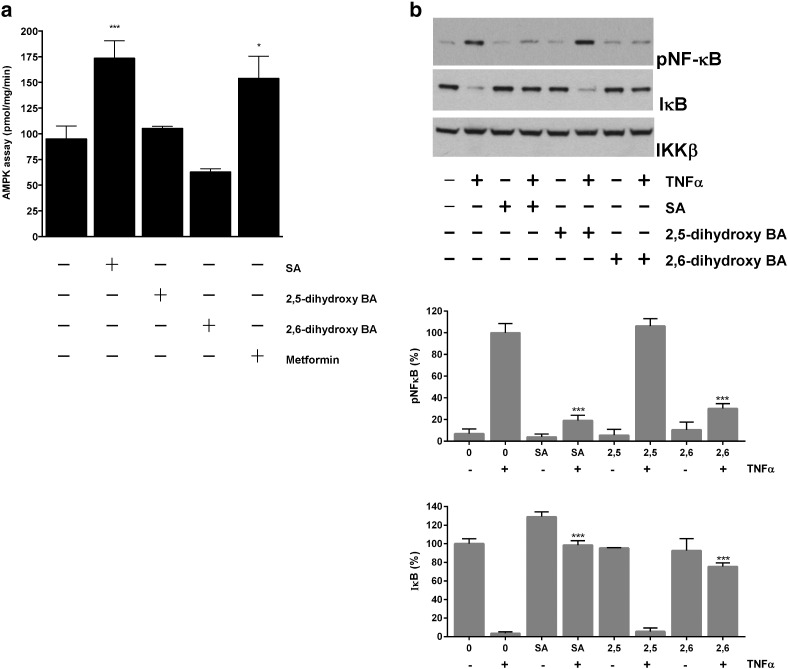
Effect of SA and analogues on AMPK activation and NF-κB signalling.(a) H4IIE cells were grown in serum-free medium for 2 h, followed by stimulation with the agents shown (10 mM) for 3 h followed by AMPK assay as described in Materials and methods. Treatments significantly different from untreated cells are shown; ⁎⁎⁎p < .001, ⁎p < .05 with respect to untreated cells. (b) HT-29 cells were serum starved overnight in 0.25% serum, prior to treatment for 1 h without or with 30 mM each of the analogues shown. The effect of each agent on IκB levels following 10 ng/ml TNF-α treatment (final 15 min) was assessed by immunoblotting. Another antibody detected total IKKβ. Densitometry of blots was carried out as described in Materials and methods. Co-incubations of drug with TNF-α significantly different from TNF treatment alone are shown. For both antibodies, TNF-α plus salicylate n = 7, TNF-α plus 2,6-DHBA n = 4.